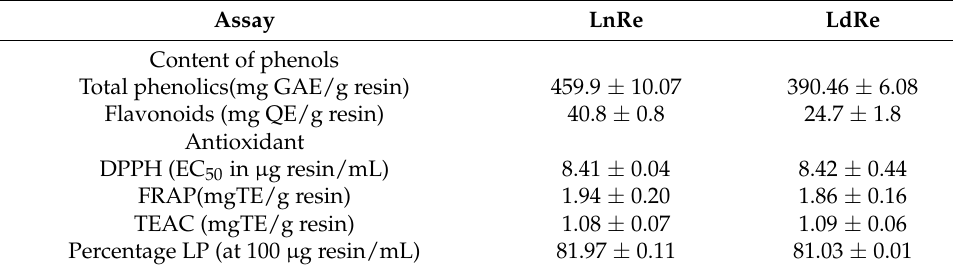
Table 2. Antioxidant properties and total phenolics and flavonoids content of LnRe and